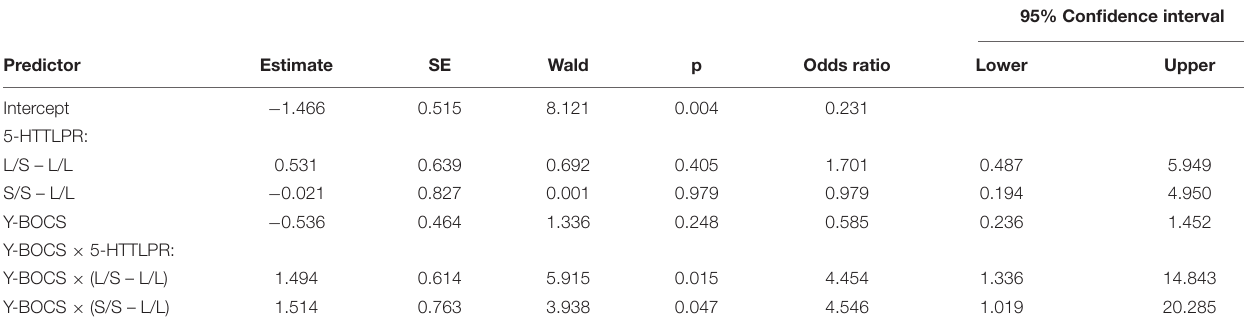
TABLE 4 | Logistic regression analysis predicting lifetime suicide attempts from 5-HTTLPR, chronic OCD symptoms, and the interaction between 5-HTTLPR and chronic OCD symptoms.